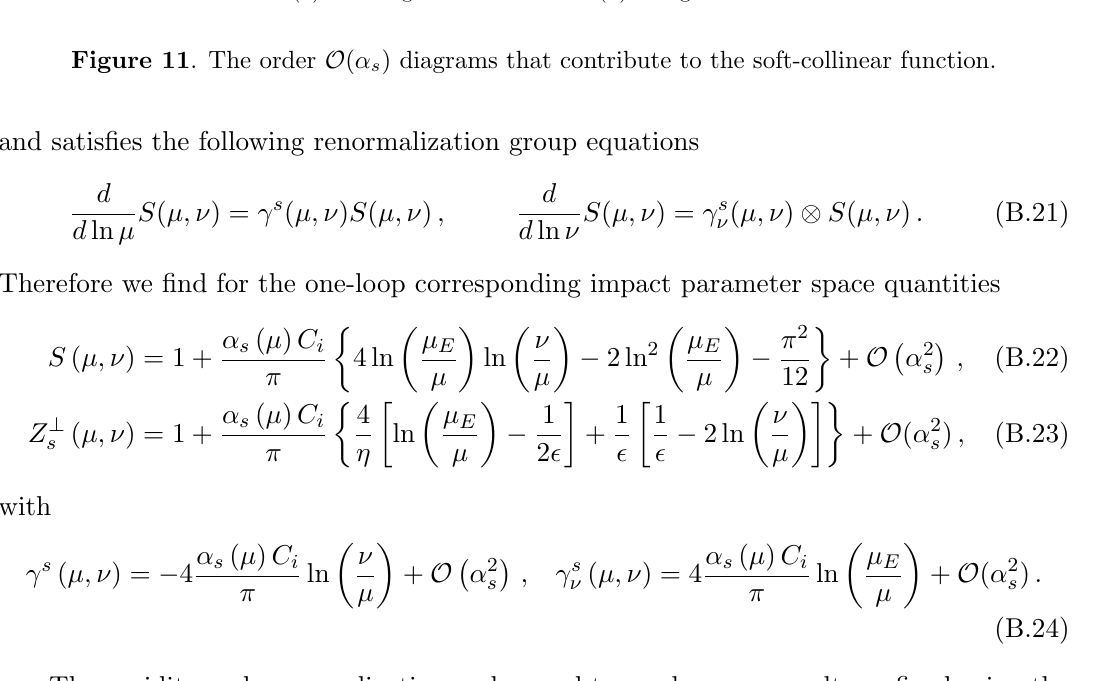
Figure 11 . The order